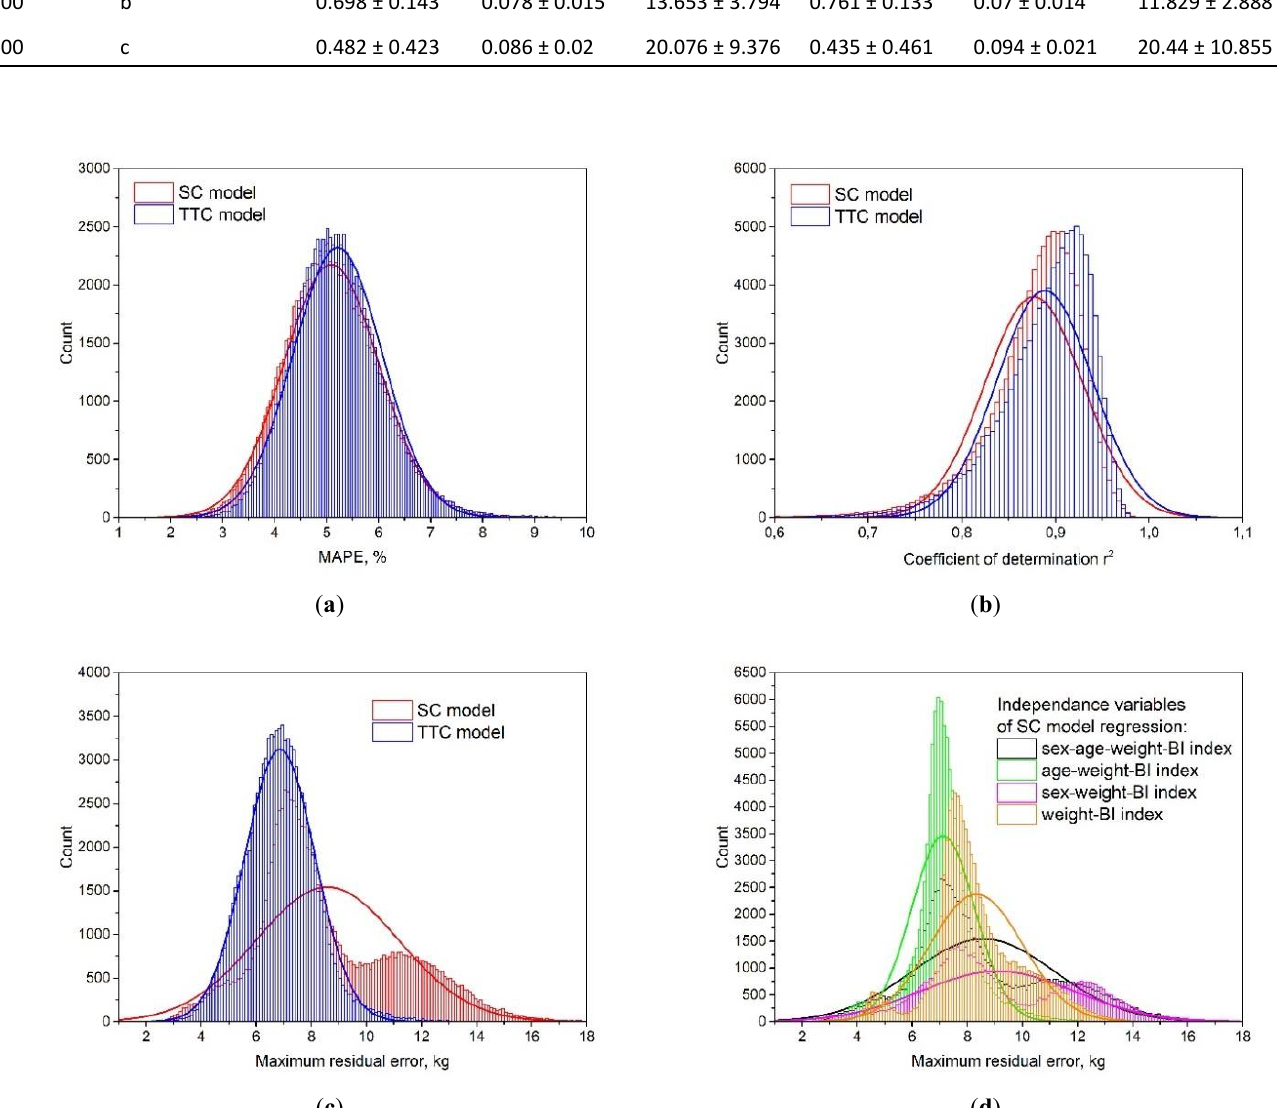
Fig.5: (a) MAPE; (b) Coefficient of determination r 2 ; (c) Maximal residual error. Distribution shapes were obtained during 100,000-sample bootstrap procedure. Bold lines show normal approximation curves; (d) The effect of sex and age variables on maximal residual error distribution for the single cylinder